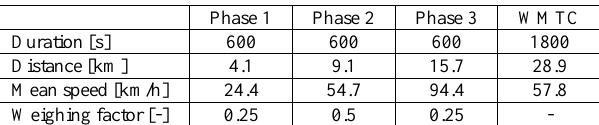
Table 1. Characteristics of the WMTC and its phases